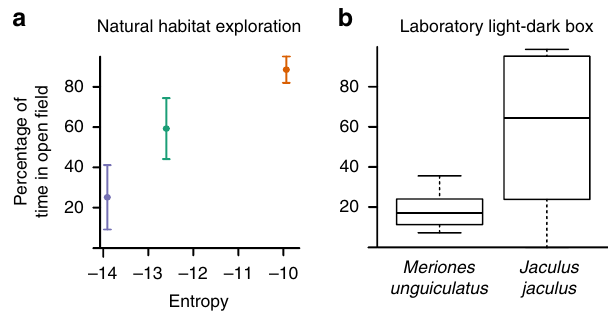
Fig. 5 Bipedal, and more unpredictable, locomotion is associated with lower open- fi eld anxiety in sympatric desert rodents. a Percentage of observed time spent in open fi eld by species, as a function of the entropy of each species ’ trajectories during simulated predation trials in the natural habitat enclosures. The quadrupedal jird, Meriones sp., is shown in blue , the bipedal jerboa, Dipus sagitta , is shown in green , and the bipedal jerboa, Allactaga elater , is shown in orange . Error bars indicate 95% con fi dence intervals for each species ( n ( Allactaga elater ) = 14 videos, n ( Dipus sagitta ) = 6 videos, n ( Meriones sp.) = 5 videos). b Percentage of time spent in open fi eld is signi fi cantly different between species in laboratory Light-Dark Box trials (Welch Two Sample t -test: P = 0.005, t = − 3.4113, df = 11.756, 12 J. jaculus trials, 18 M. unguiculatus trials). The boxes span the interquartile range, the bold line represents the median, the whiskers extend to 1.5 times